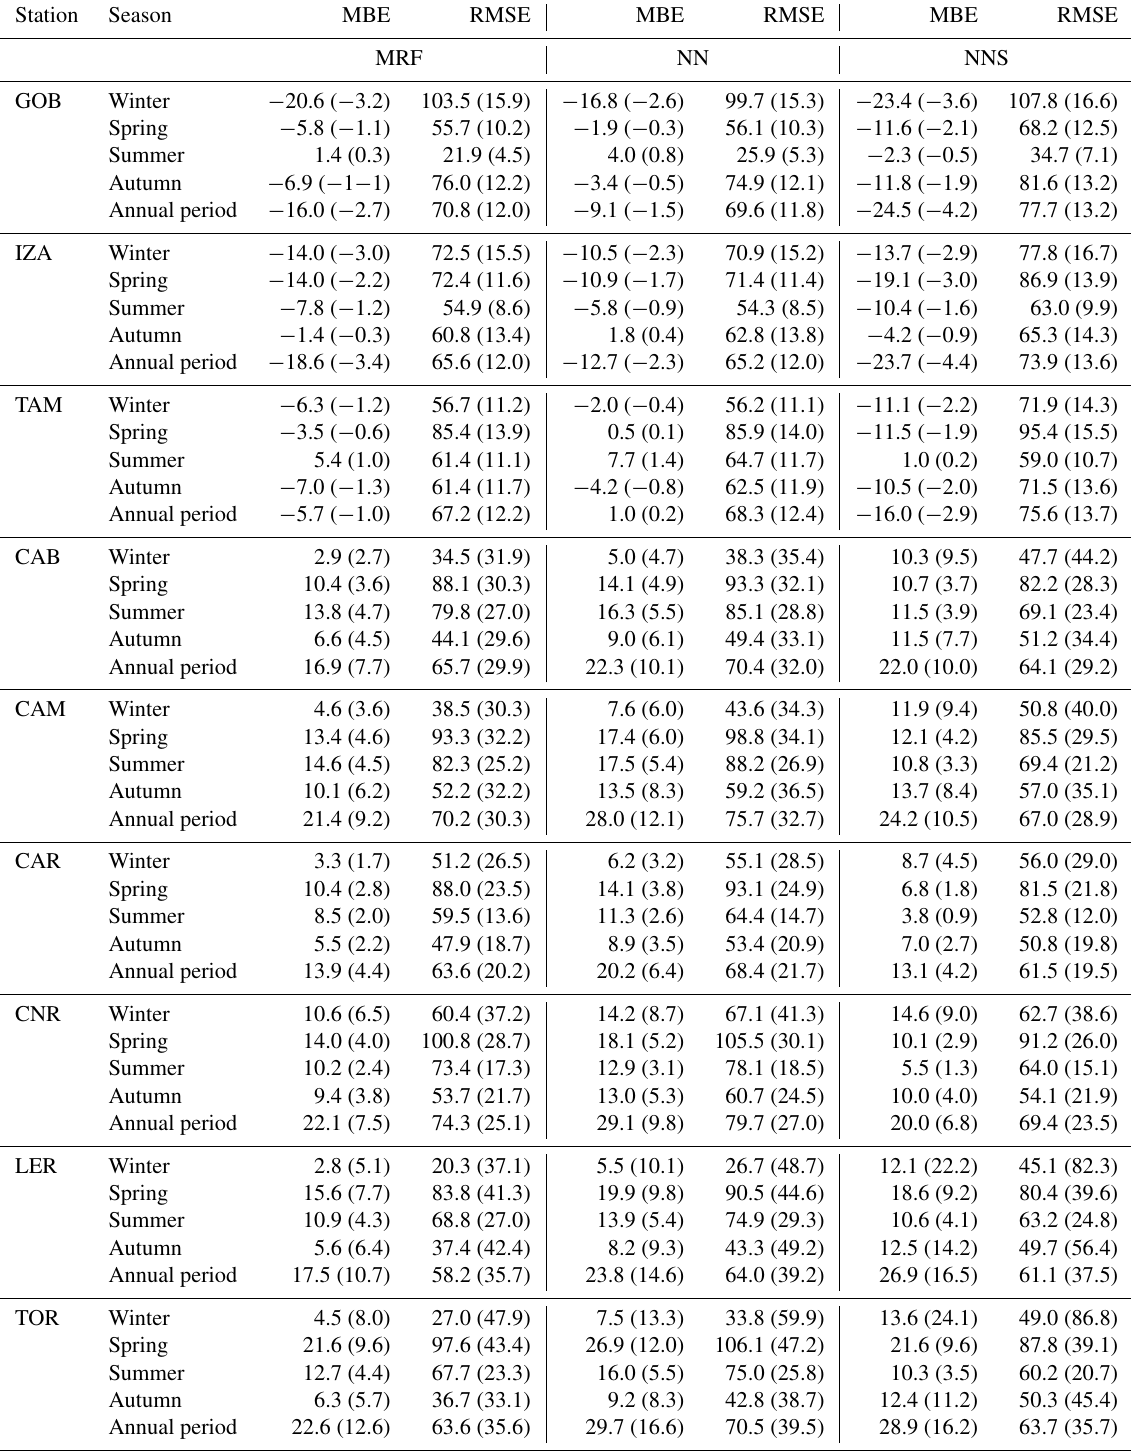
Table 4. GHI evaluation results as a function of season and real-time techniques for all stations. The model MBE and RMSE statistical scores are shown in absolute units (Wm − 2 ) and as relative magnitude (percentages in